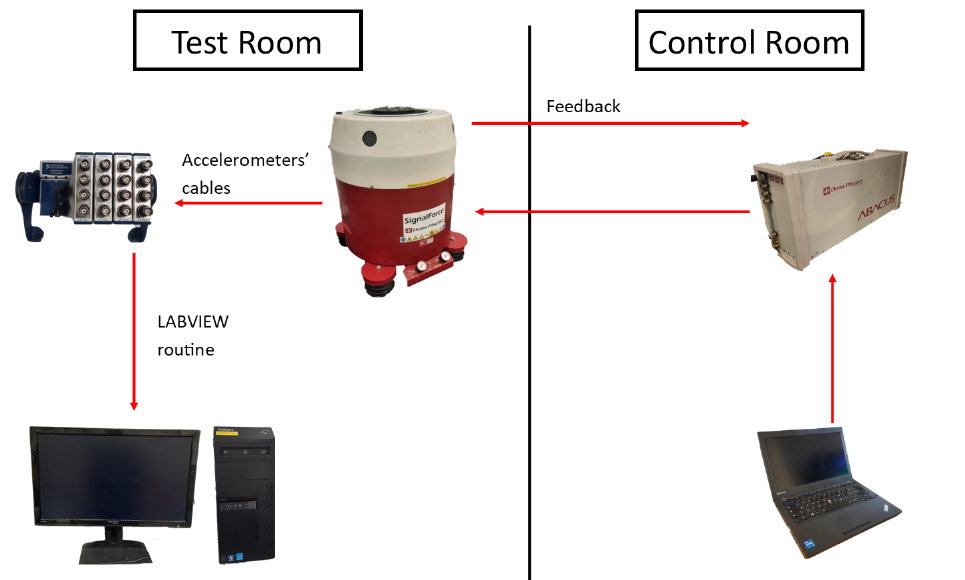
Figure 7. Testing